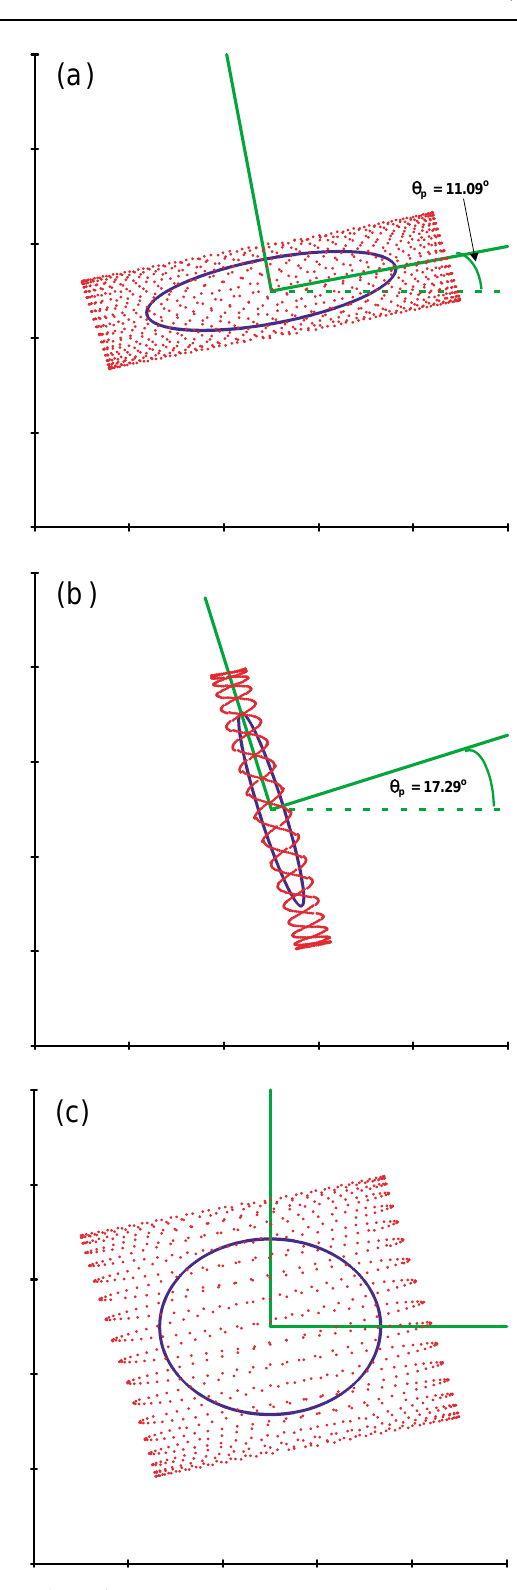
FIG. 3. (Color) Numerical calculation of the single particle mo- tion in the (cid:1) X - Y (cid:2) plane The action ratios between horizontal and vertical motion planes are 1:10, 10:1, and 1:1 in parts (a), (b), and (c), respectively. The angle u p is given in degrees. The ellipse represents the cross section of the averaged (cid:1) X - Y (cid:2)